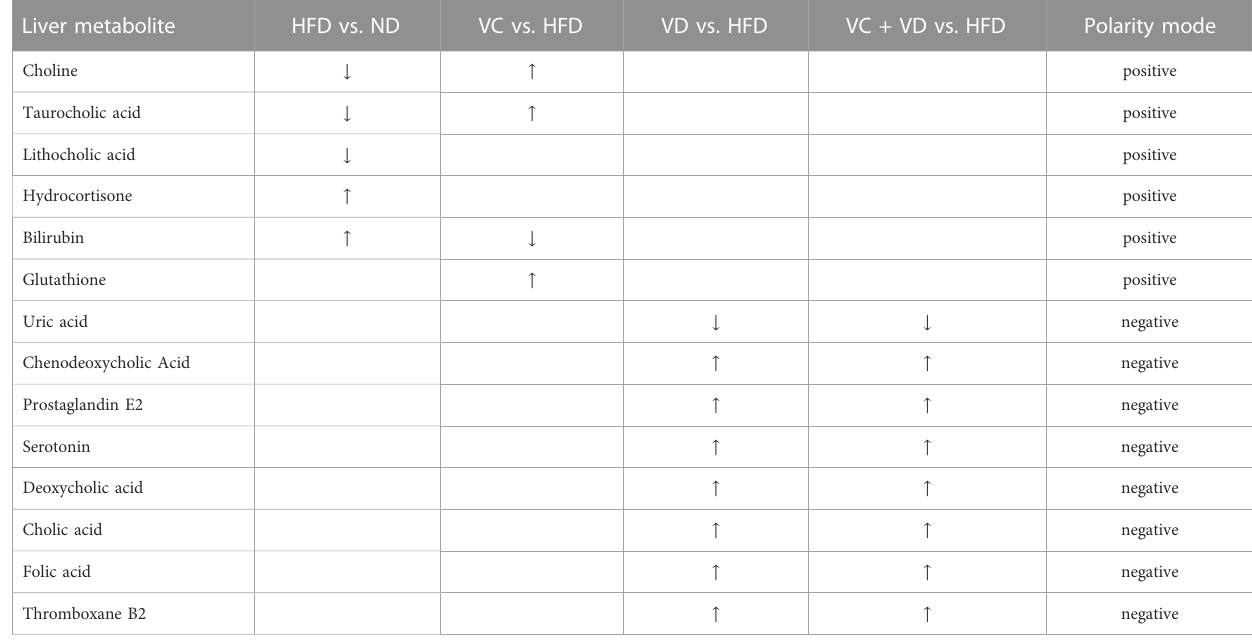
TABLE 3 The changes of liver metabolism pro fi le as for bile secretion pathways. Liver